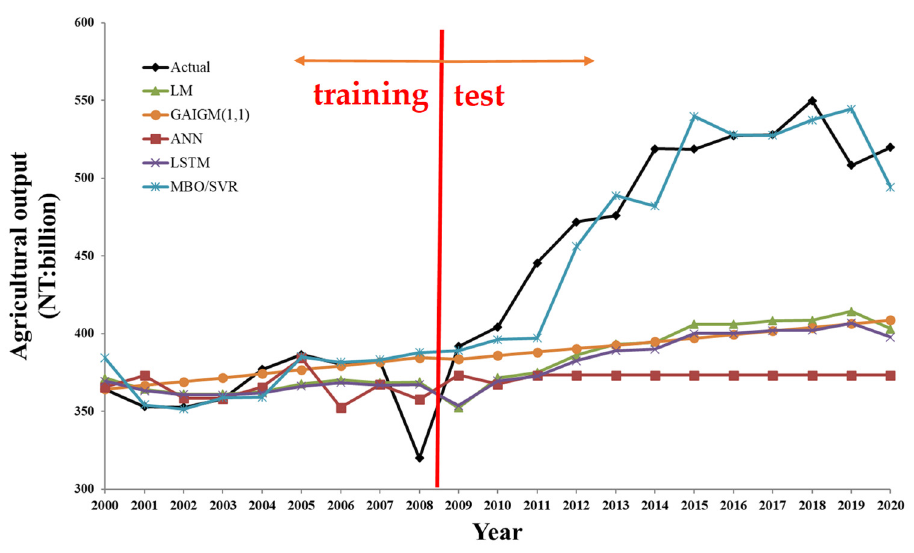
Figure 5. The prediction results of the models.